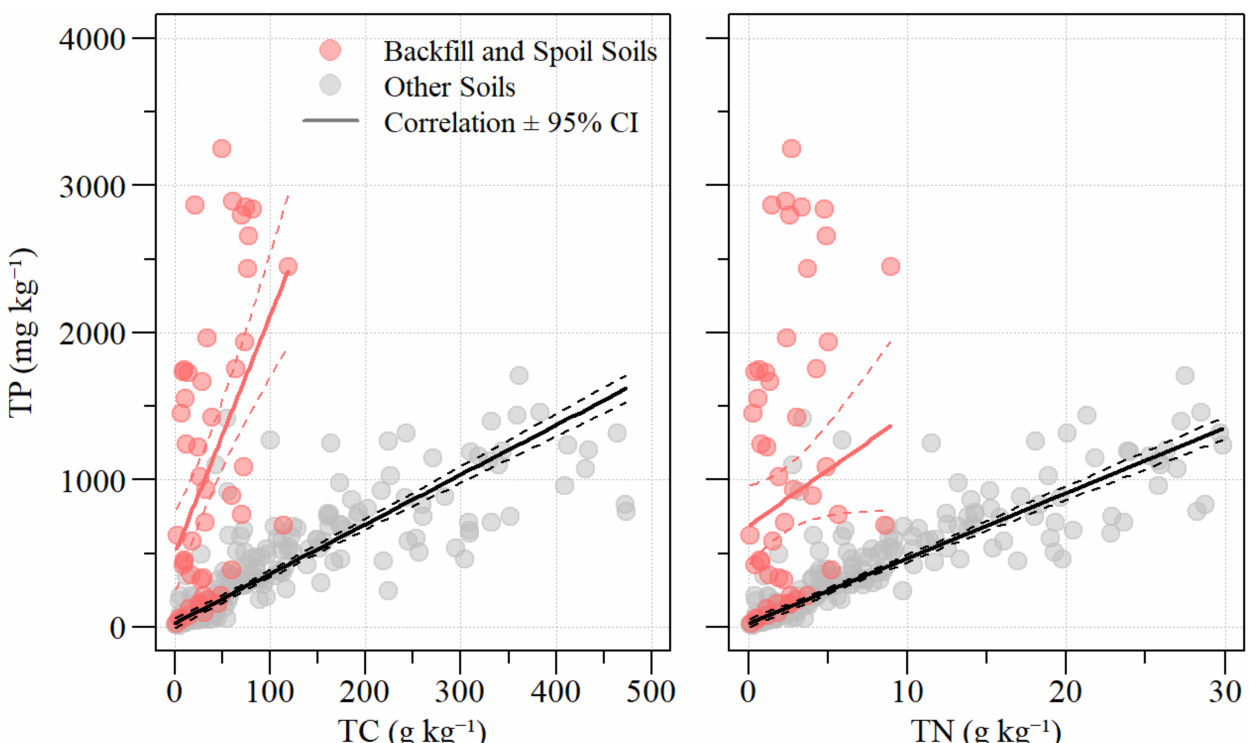
Figure 6. Comparison of soil total phosphorous (TP) and total carbon (TC) and TP and total nitrogen (TN) between backfill and spoil soils versus other soils with correlations identified.